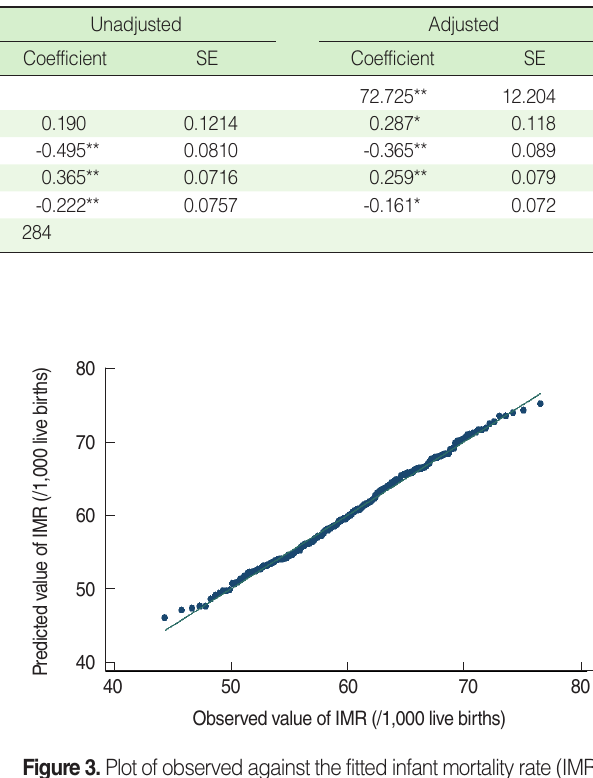
Table 2. Unadjusted and adjusted coefficients and SE for the ordinary least squares regression analysis of the effect of ecological factors on the IMR